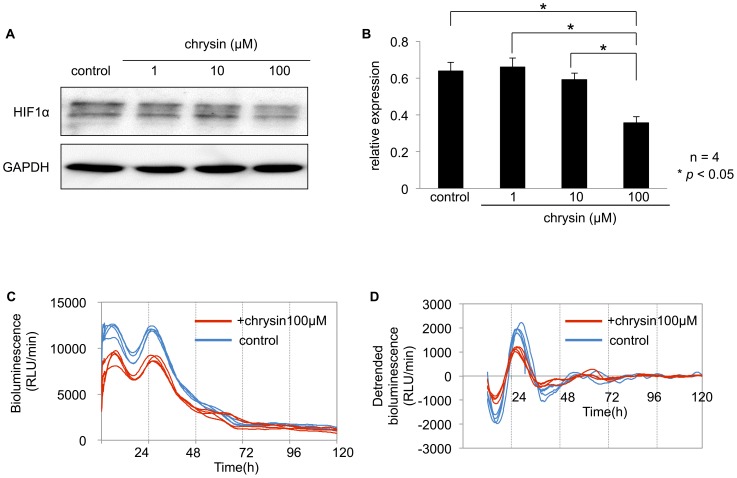
The effect of HIF1α inhibition on Per2 circadian rhythm in Caki-2 cells.(A) Caki-2 cells were cultured to 60–70% confluence. The cells were treated with DMSO as a control, or different chrysin concentrations (1, 10, 100 µM) for 2 h. (B) HIF1α protein levels were measured in optical density values normalized to their respective GAPDH loading control, then averaged ± SEM, and graphed (relative expression) to semiquantitatively compare protein levels (n = 4). HIF1α expression was significantly suppressed by 100 nM chrysin compared to the control incubated with DMSO (p<0.05, one-way ANOVA followed by Tukey's post hoc test). (C) Caki-2 cells were transfected with the Per2 promoter reporter (2 µg). Twenty-four hours after the transfection, cells were incubated with 100 µM chrysin or DMSO for 2 h. Bioluminescence was then measured using a real-time monitoring assay. The luciferase activities of four replicate samples are shown. (D) Detrended bioluminescence is shown. Period, amplitude, and acrophase of the oscillations were measured on days 2 to 5 using the Cosinor software (Circadian Rhythm Laboratory). Amplitude significantly decreased (mean ± SEM, n = 4) compared to the control (p<0.05). See Table 3.